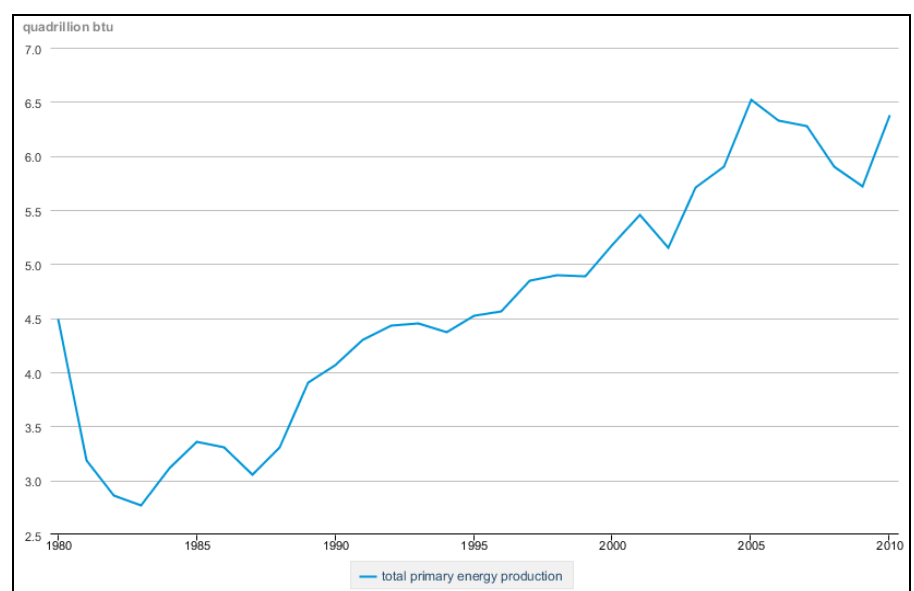
Fig. 7. Nigeria total primary energy production (1980–2010). [22]